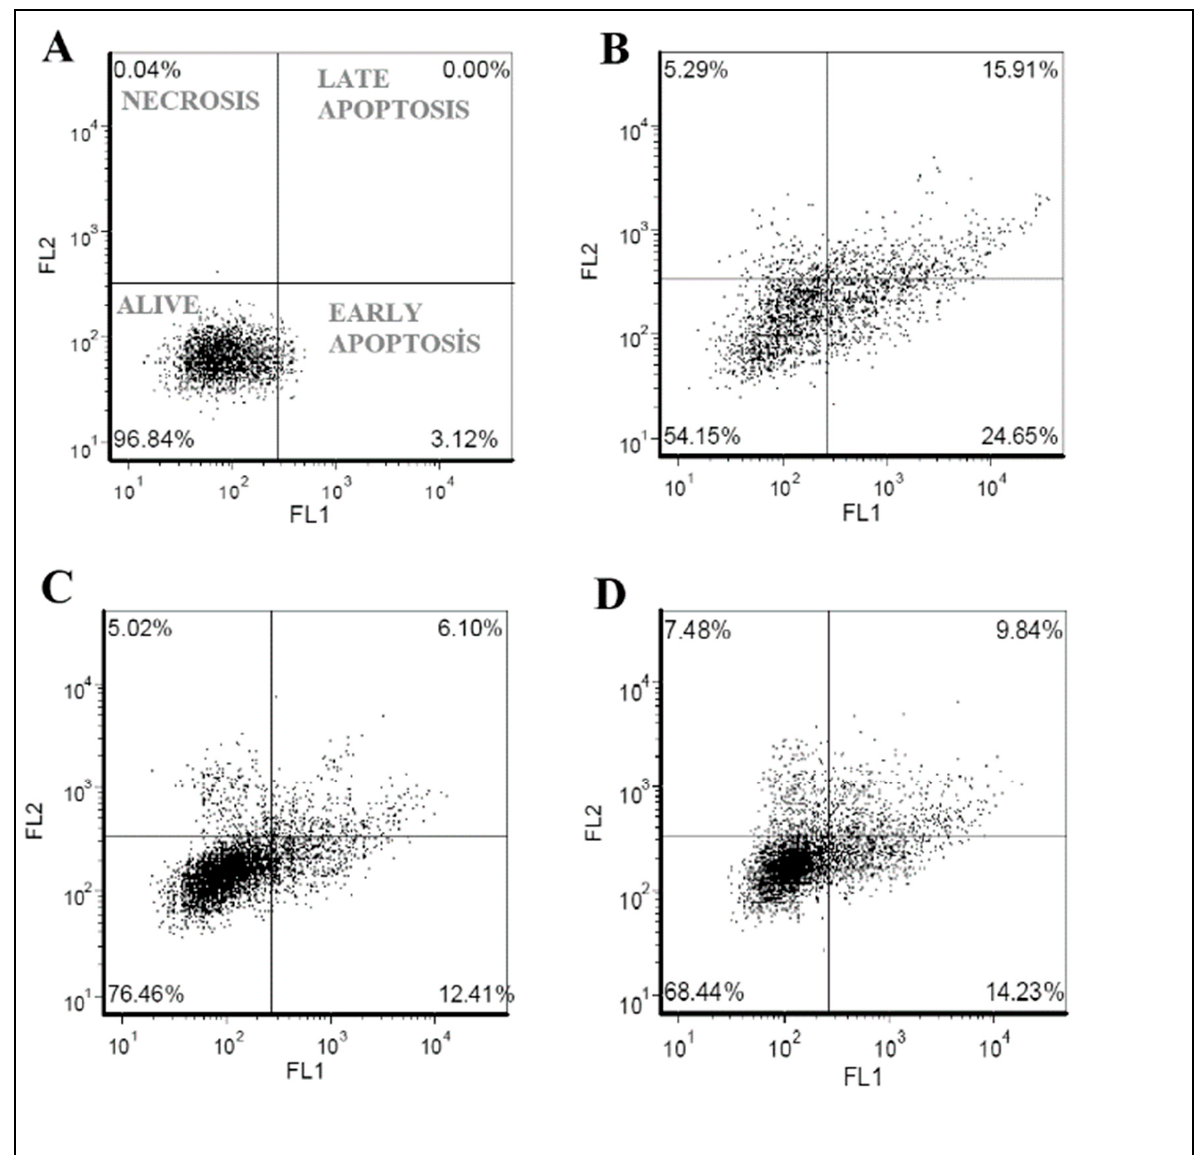
Figure 11. Flow cytometry analysis of compound application in cellular PD model. ( A )—negative control (differentiated SH-SY5Y cell culture), ( B )—MPP+ is applied to differentiated cell culture (cellular PD model), ( C )—costunolide (100 µg/mL) is applied to cellular PD model, and ( D )—parthenolide (50 µg/mL) is applied to cellular PD model.